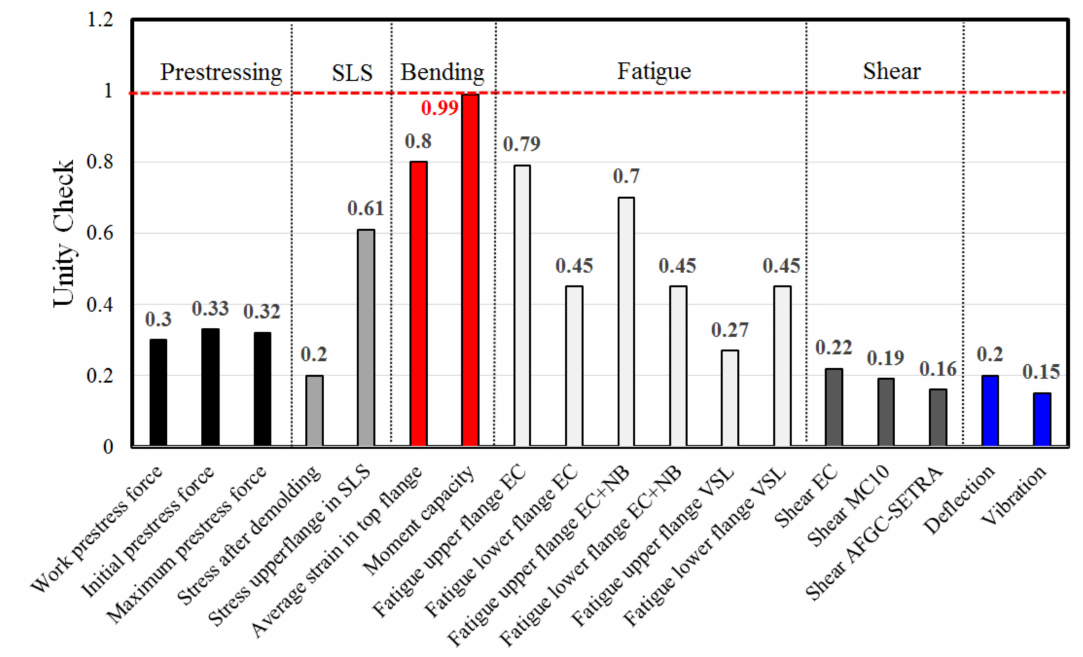
Figure 9. Outcome of the calculation with BoDeTo (ULS bending criteria is